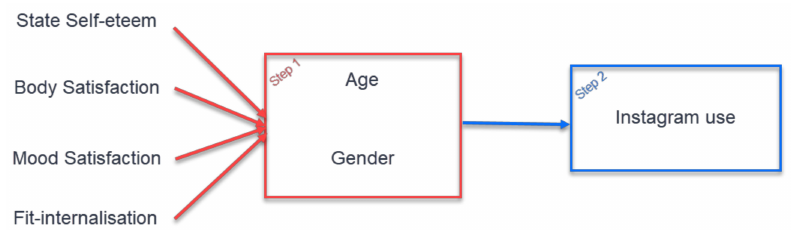
Figure 1. The two-step regression statistical analysis which includes age and gender in first step and Instagram use in the second